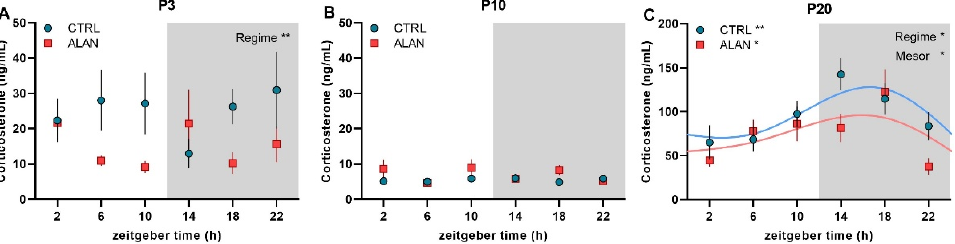
Figure 1. Effects of gestational dim ALAN (~2 lx) on the early development of daily melatonin rhythms. Pineal melatonin rhythms on postnatal day P10 ( A ) and P20 ( B ) and plasma melatonin rhythms on P3 ( C ), P10 ( D ), and P20 ( E ) in rat pups that were delivered by mothers exposed to either the control light–dark cycle (CTRL) or ALAN during pregnancy. Symbols represent the mean ± SEM, n = 3–6 rats per time point and group. The significant 24-hour rhythms are fitted with a cosine curve for CTRL (blue solid line) and ALAN (red solid line) groups at *** p < 0.001 and * p < 0.05. Non-rhythmic data are not fitted with the cosine curve. Significant group differences in the rhythm amplitude and the main effects of the Regime from two-way ANOVA are indicated at * p < 0.05. - Zeitgeber time 0 = light on. Grey area represents the dark phase. Note different scales in graphs. Estimates of mesor (the time series mean), amplitude (one-half the peak-to-trough difference), and acrophase (the peak time of the fitted curve) ± 95% confidence limits, ZT—zeitgeber time. R2, F, and p -values describe the significance of 24-h rhythms. Differences in mesor, amplitude, and acrophase between the CTRL and ALAN groups were evaluated based on 95% confidence intervals and using Wald tests. * p < 0.05. Plasma corticosterone concentrations, as a main output of the hypothalamus-pituitary- adrenal axis, did not exhibit significant daily rhythms in either CTRL or ALAN groups in P3 and P10 (Figure 2A,B and Table 1). However, two-way ANOVA revealed lower mean corticosterone levels in 3-day-old ALAN pups compared to controls (F (1,58) = 9.25, p < 0.01; Figure 2A). On P20, daily corticosterone rhythms were detected in both the CTRL ( p < 0.01) and ALAN groups ( p < 0.05; Figure 2C), but mean corticosterone levels were lower in ALAN compared to CTRL pups, as indicated by differences in mesor ( p < 0.05; Table 1) and confirmed by two-way ANOVA (factor regime: F (1,59) = 4.36, p < 0.05; Figure 2C).